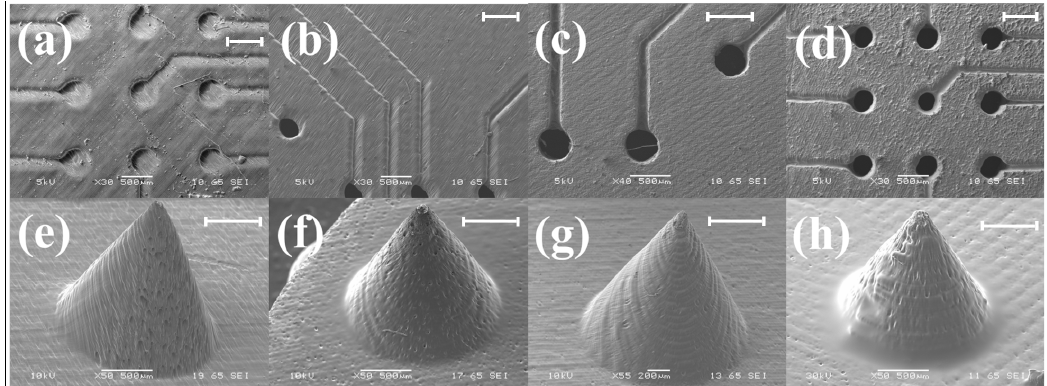
Figure 5. Effect of the angle at which the MEAs and MNs are 3D printed with respect to the horizontal axis. ( a – d ) MEAs printed at angles 0°, 45°, 60° and 90° respectively and ( e – h ) MNs printed at angles 0°, 45°, 60° and 90° respectively. The scale bars in the figure correspond to a measurement of 500 μm.